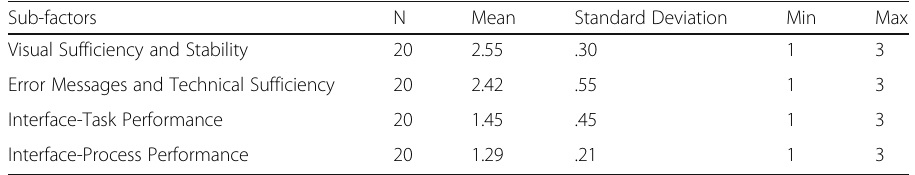
Table 4 Descriptive statistics about the usability and its